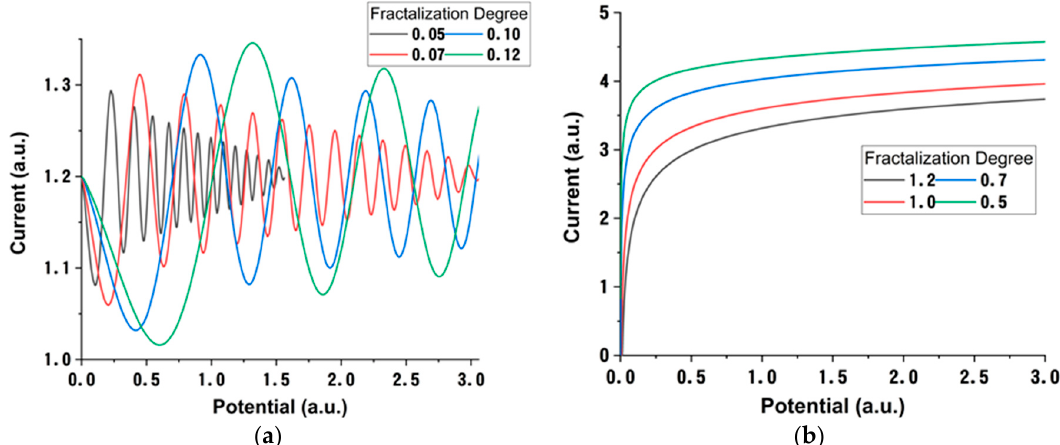
Figure 7. Current dependence with fractal potential in various domains of fractal degree <0.2 ( a ) and >0.5 ( b ).